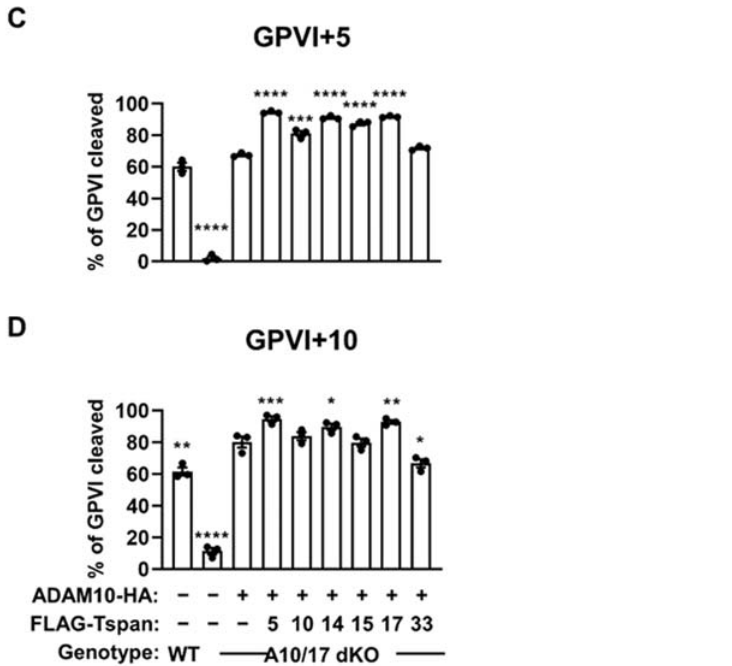
Figure 7. Evidence that cut site position on GPVI contributes to specific cleavage by Tspan15/ADAM10 and Tspan33/ADAM10. ( A ) Amino acid alignment of wild-type GPVI and the stalk extension mutants, GPVI+5 and GPVI+10: ADAM10 cut site is denoted by ˆ; residues inserted are highlighted in grey; transmembrane region is underlined. ( B ) Wild-type (WT) HEK-293T cells were transfected with expression constructs for C-terminally Myc-tagged GPVI and FcR γ (+) or empty vector (–). ADAM10/17 double knockout (A10/17 dKO) HEK-293T cells were co-transfected with GPVI and FcR γ , HA-tagged ADAM10 alone, or in combination with FLAG-tagged TspanC8s (Tspan5, 10, 14, 15, 17 or 33). Cells were lysed in 1% Triton X-100 followed by Western blotting with anti-Myc, anti-FLAG and anti-HA antibodies (data not shown). The percentage of cleaved GPVI was calculated. Cleavage assays for ( C ) GPVI+5 and ( D ) GPVI+10 was performed as described in panel B. Error bars represent the standard error of the mean from three independent experiments. Data were arcsine-transformed and statistically analyzed using a one-way ANOVA followed by a Dunnett’s multiple comparison test, compared to A10/17 dKO cells transfected with ADAM10 alone (*, p < 0.05; **, p < 0.01, ***, p < 0.001; ****, p <